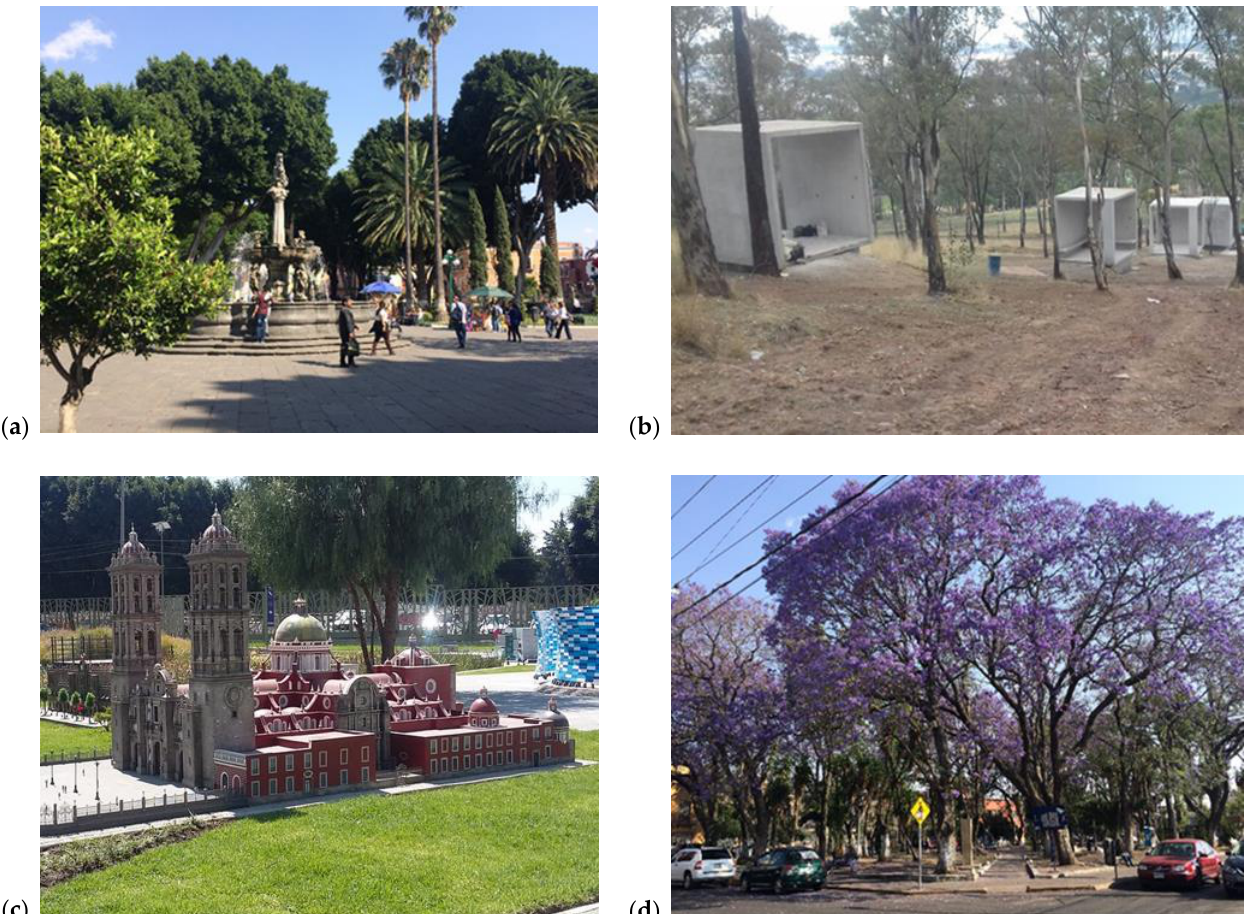
Figure 4. Date palm and Indian laurel trees in the Zocalo park of Puebla ( a ), Eucalyptus trees in Amalucan Hill park ( b ), grass in La Constancia/Paseo de Los Gigantes or “model park” ( c ), and blossoming Jacaranda trees in the Federico Escobedo park ( d ).